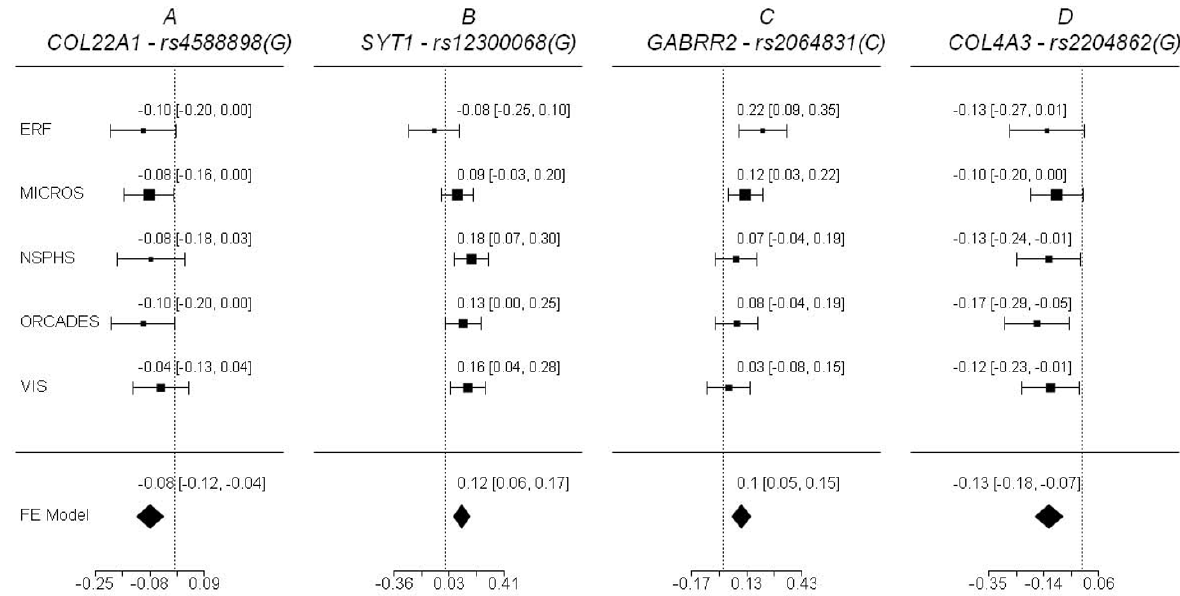
gamma-aminobutyric acid receptor rho-2 ( GABRR2 ) and the ubiquitin-conjugating enzyme E2-J1 ( UBE2J1 ) genes (Figure 6). Five additional SNPs (out of a total of 28 SNPs tested) in this region had p values between 2.2 × 10 -3 and 0.0280 (Table 4). Of the 37 SNPs genotyped in the popgen sample, eight were associated with S with CR a p value ≤ 0.05; seven of them overlapped with the GABRR2 and UBE2J1 genes (see the blue squares in Figure 6). The most consistent association signals in EUROSPAN and popgen were found near the GABRR2 gene and its promoter, and the respective SNPs were in linkage disequilibrium (r 2 > 0.59, Figure 6, middle panel). SNP rs12195070 was genotyped in both EURO- SPAN and popgen: effect direction was discordant but p values of 4.5 × 10 -3 in EUROSPAN and p value = 7.2